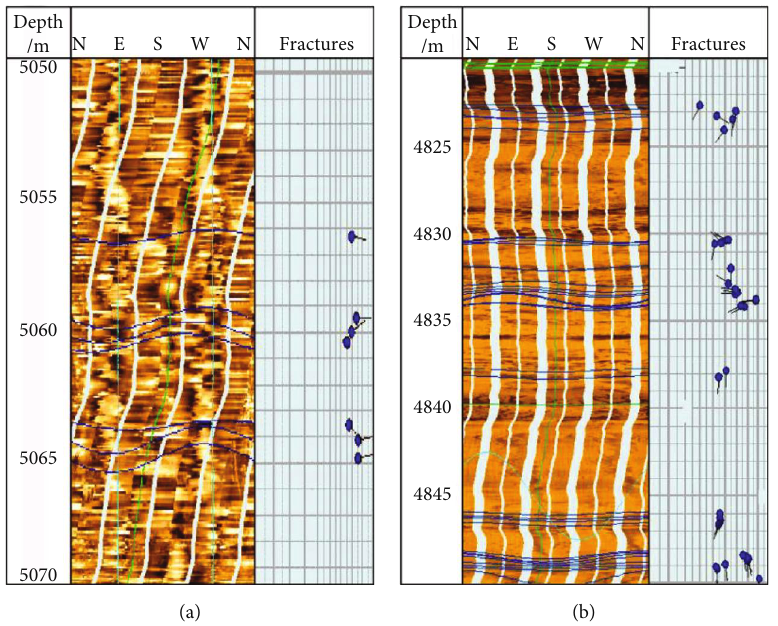
Figure 9: Fracture identi fi cation with imaging logging. (a) Well BD102, 5055-5070m; Ahe Formation of Jurassic. (b) Well DX1, 4820- 4850m; Ahe Formation of